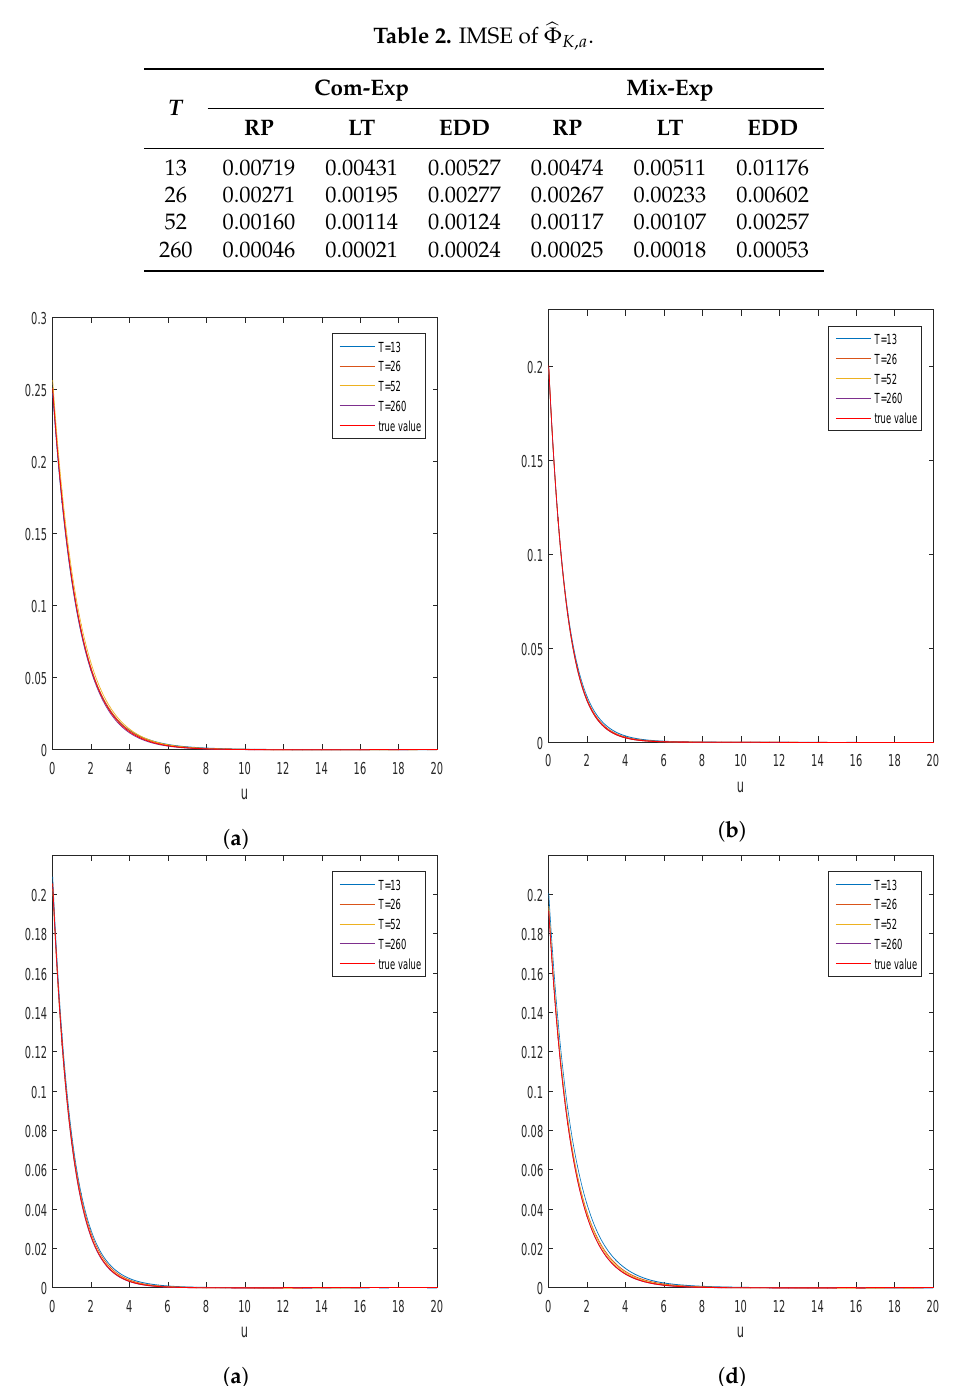
Figure 3. Estimation of the expected discounted deficit at ruin due to a claim for different claim sizes. Mean curves: ( a ) exponential claim sizes; ( b ) Erlang claim sizes; ( c ) combined-exponential claim sizes; and ( d ) mixed-exponential claim